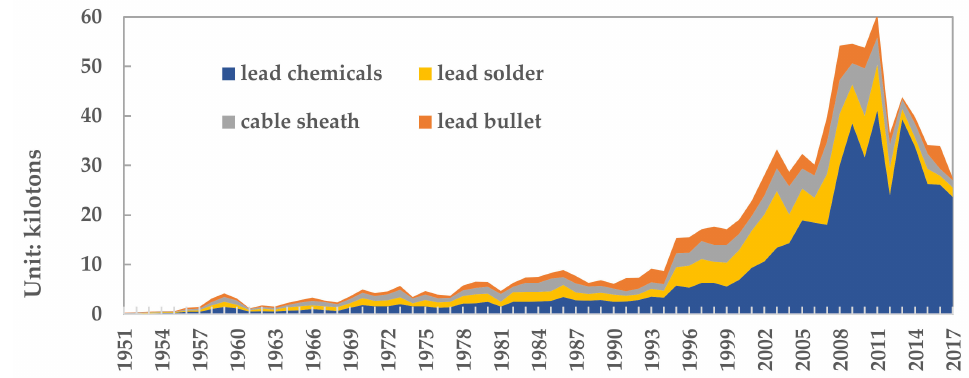
Figure 6. The loss of lead in the use stage of lead products from 1949 to 2017. (Data source: China Non-ferrous Industry Association).